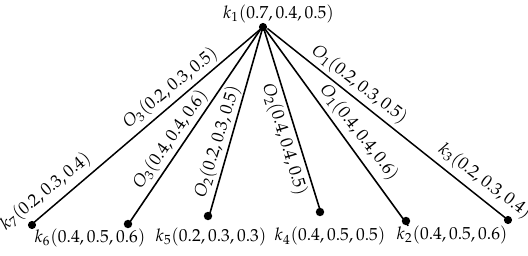
Figure 13. Totally-strong self-complementary